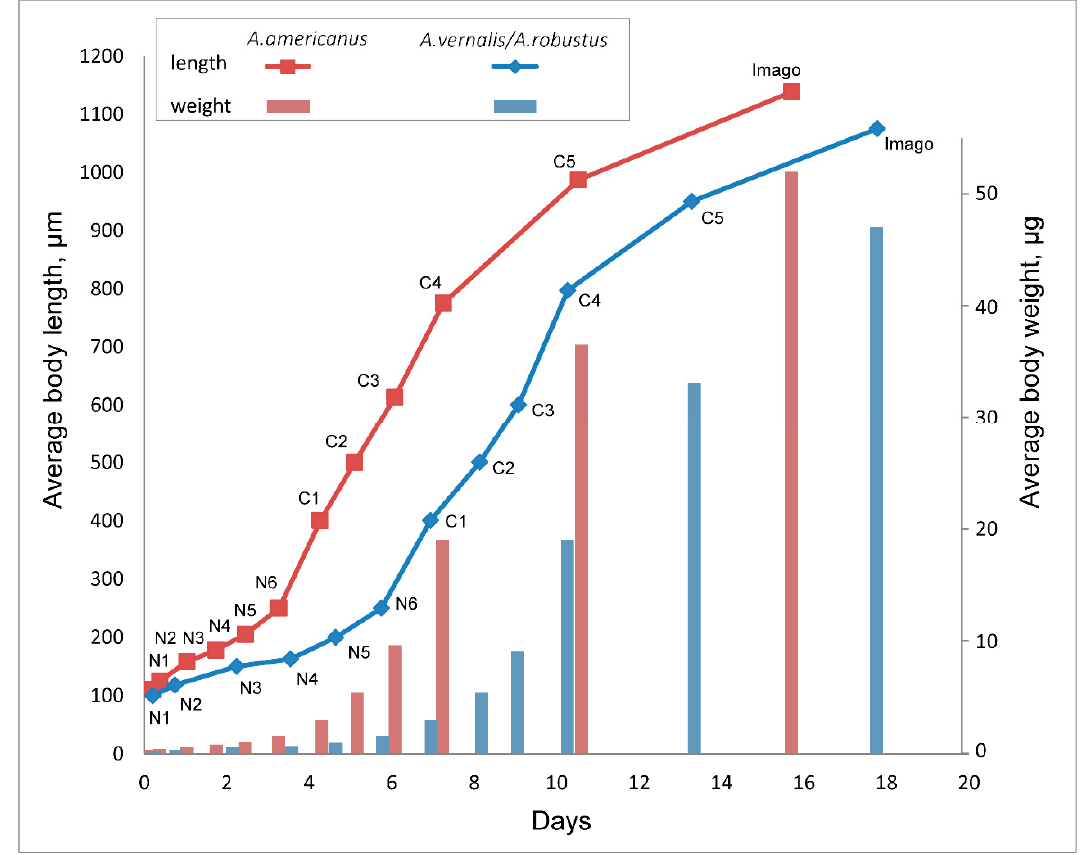
Figure 4. Development time and body length/weight of invasive Acanthocyclops americanus and two native Acanthocyclops species.